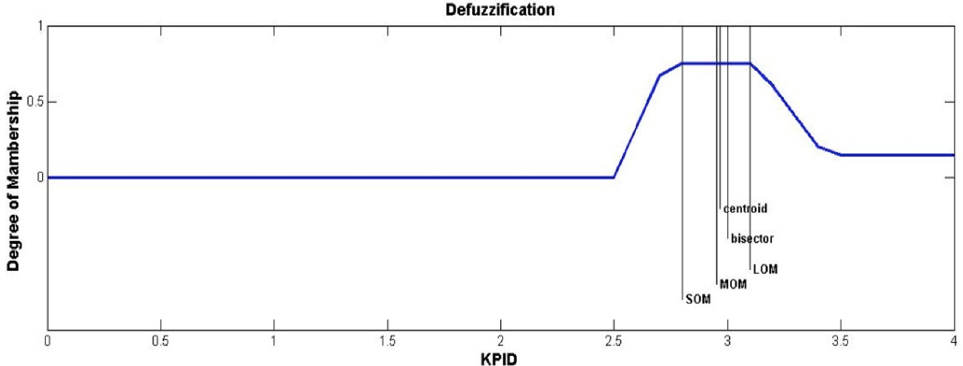
Figure 10. of Defuzzification with COA, bisector, MOM, LOM, and SOM methods. Figure 10. Defuzzification with COA, bisector, MOM, LOM, and SOM